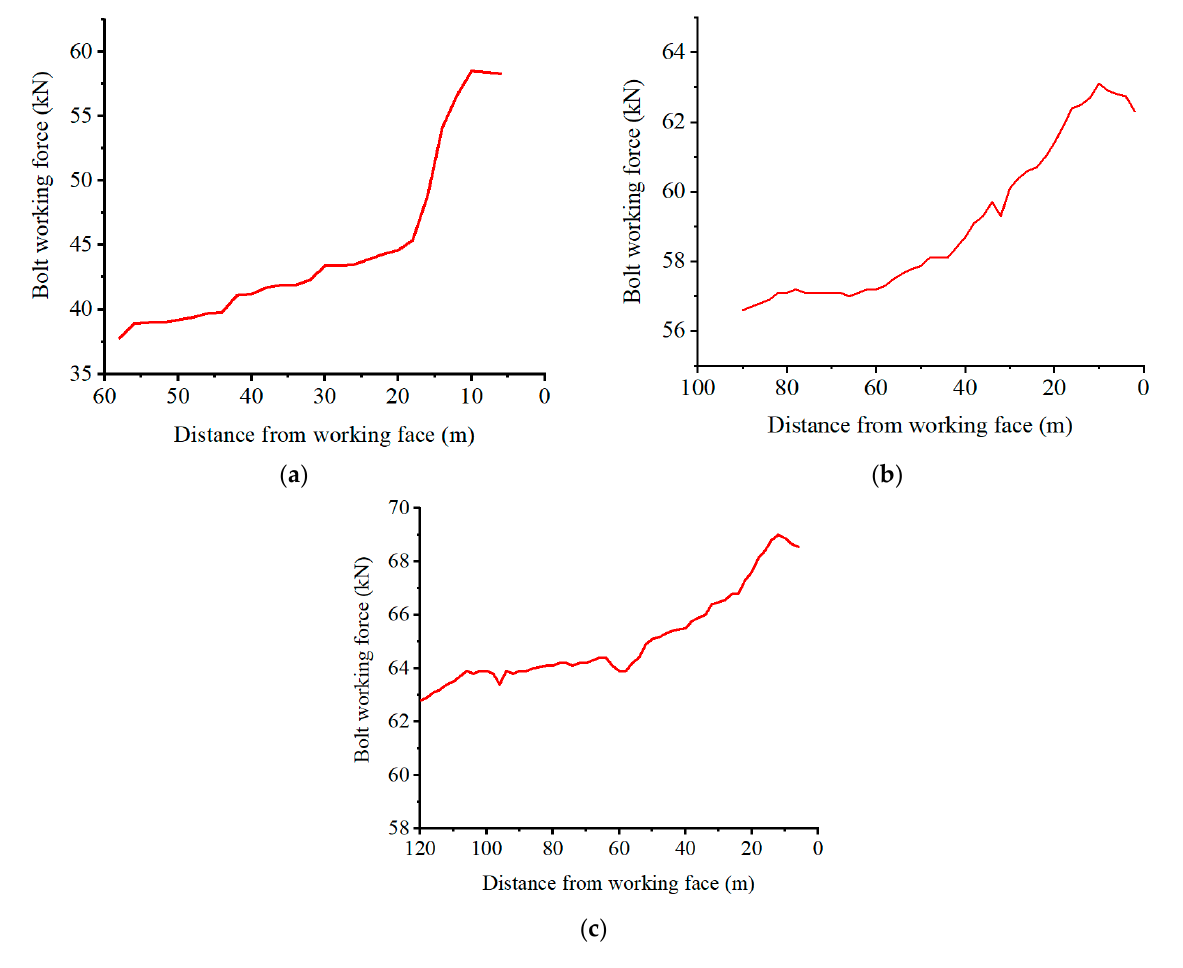
Figure 19. Force of bolts. ( a ) Station 1# ( b ) Station 2# ( c ) Station 3#.